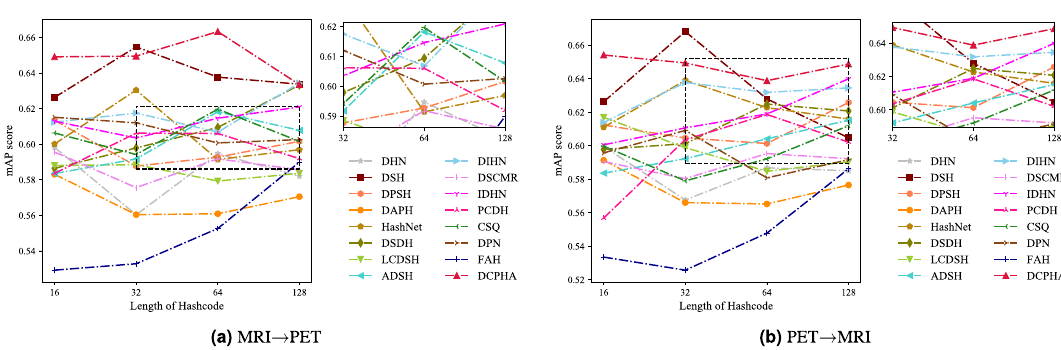
Figure 4. The precision curves of DCPHA and comparisons on OASIS3 dataset.